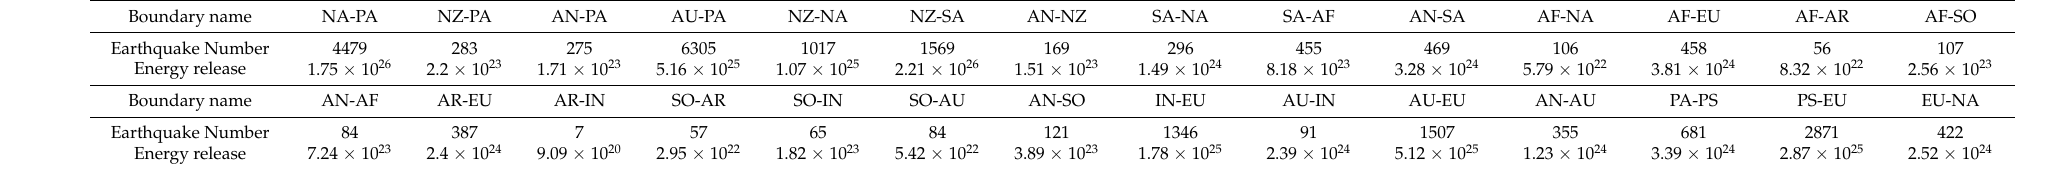
Table 1. Earthquakes and energy release at plate boundaries.